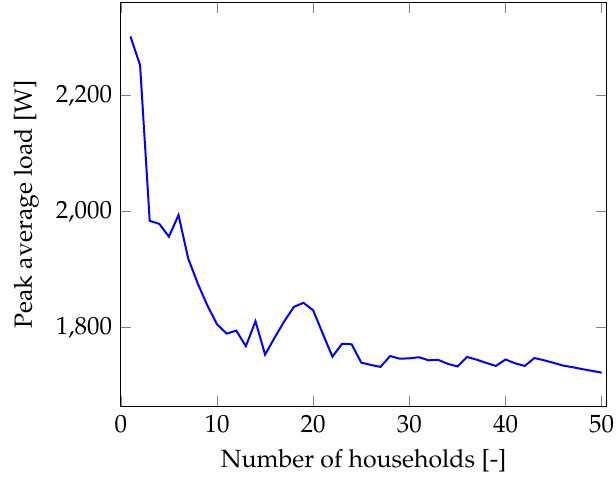
Figure 14. Change in peak average load with increasing microgrid size for tier 5.